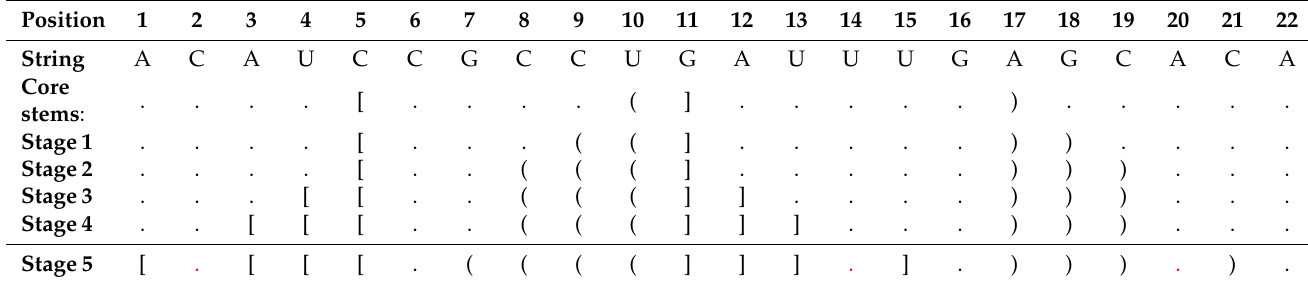
Table 1. The decoration process around the core stems of an H-type pseudoknot. Unpaired bases forming a bulge or internal loop are represented with red